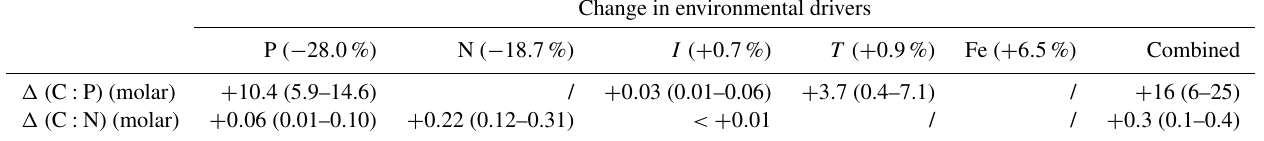
Table 3. Projected changes in C : P (molar) and C : N (molar) between 1981–2000 and 2081–2100 given model-based projected changes in environmental drivers from Boyd et al. (2015). Changes in C : N and C : P are calculated separately for each driver, with s factors from Table 2 combined with reference C : N : P of 146:20:1, a global biomass-weighted mean ratio of particulate organic matter (Martiny et al., 2013b). Ranges are derived from propagating uncertainties for the weighted mean s factors in Table 2. We used Eq. (9) in the main text for estimating the combined effect of multiple drivers. Change in environmental